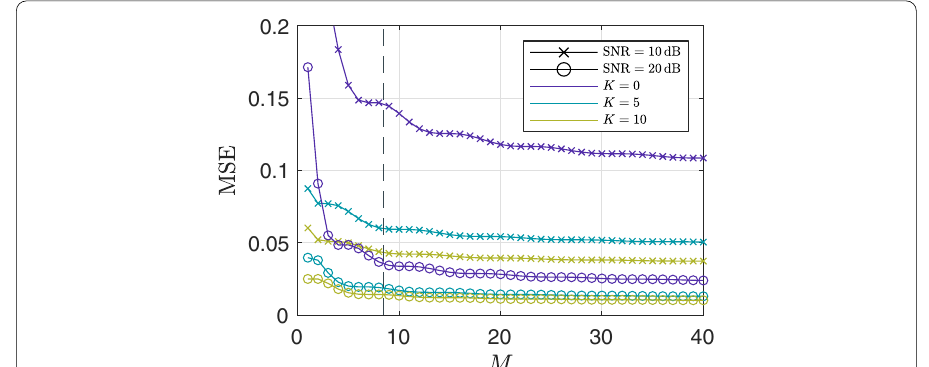
Fig. 9 Influence of the Wiener filter history length M on the MSE of the prediction. F = 10dB , (cid:31) tf m = 0.05 and N = 128 ; the dashed line is the point where M (cid:31) t equals an empirical value for the coherence time